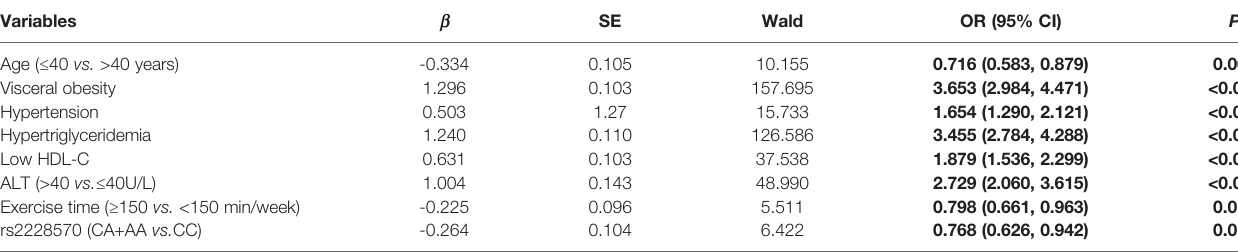
TABLE 4 | Multivariate stepwise regression analysis for independent factors of NAFLD. Variables